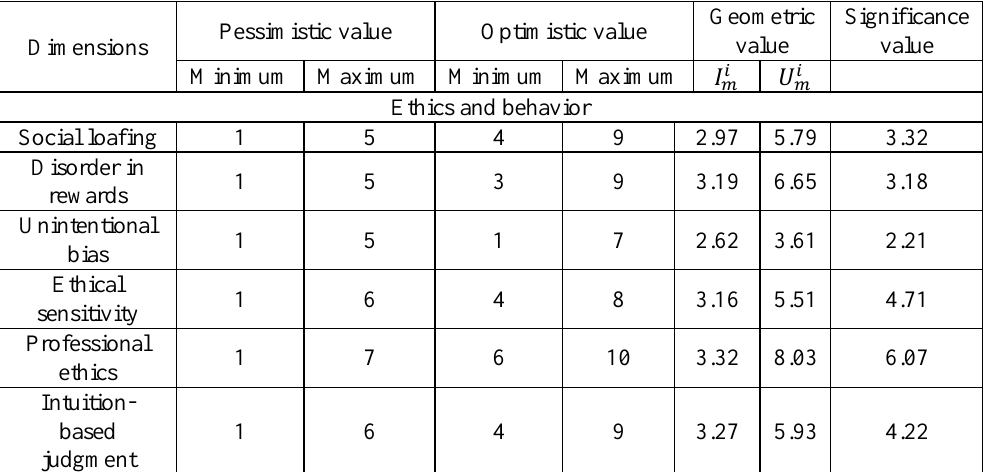
Table 5. Performance indicators based on the Fuzzy Delphi